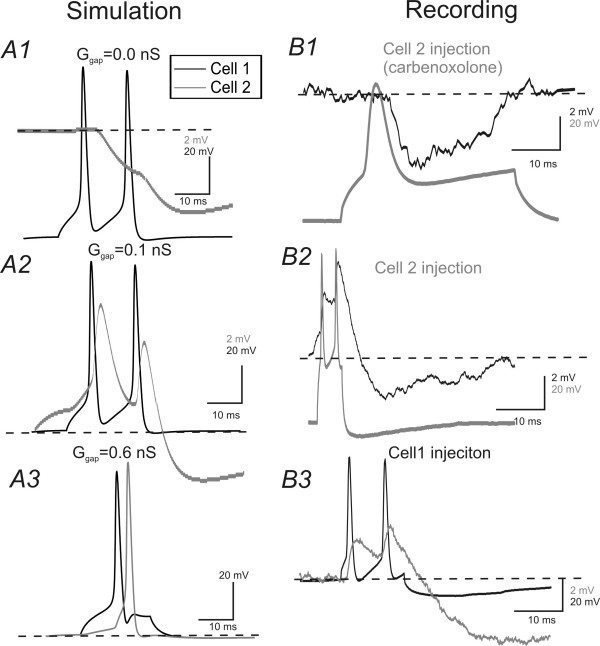
Simulation and electrophysiological recordings of GJ-mediated responses in model and real FS pairs. A1-3) Current injections (100 pA, 30 ms) in the model FS cell (black traces) induced postsynaptic responses (gray traces) in the postsynaptic model cell connected via GJs of varying strength (0, 0.1 and 0.3 nS). B1) AP (gray trace) in cell 2 induced IPSPs (black) in cell 1 with 50 μM carbenoxalone. B2 & B3) With carbenoxalone, current injection in cell 1 (black) or cell 2 (gray) induced initial depolarizing responses mediated by EPJPs followed by IPSPs.